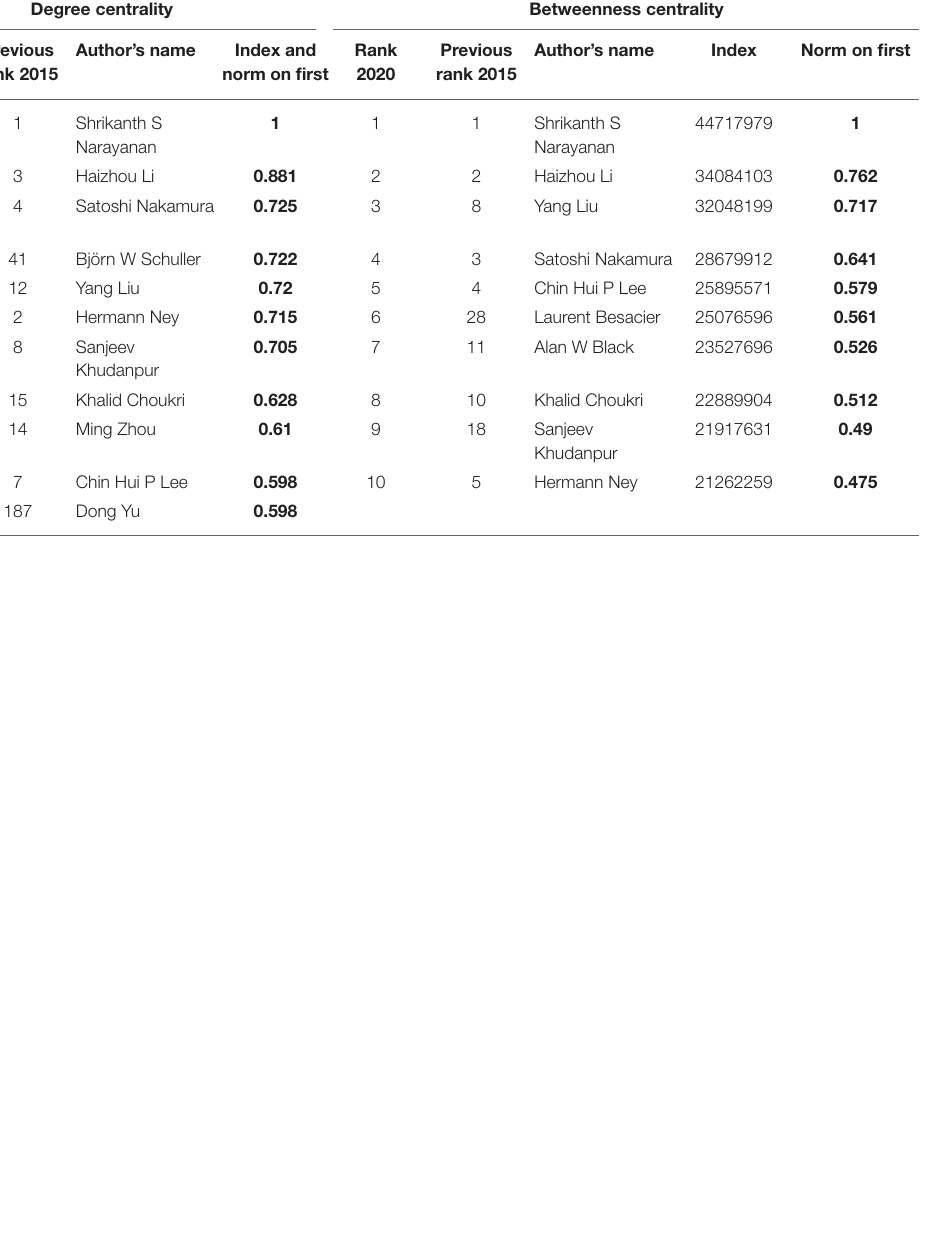
TABLE 9 | Computation and comparison of the closeness centrality, degree centrality, and betweenness centrality for the 10 most central authors (up to 2020, in comparison with 2015). Closeness centrality Degree centrality Betweenness